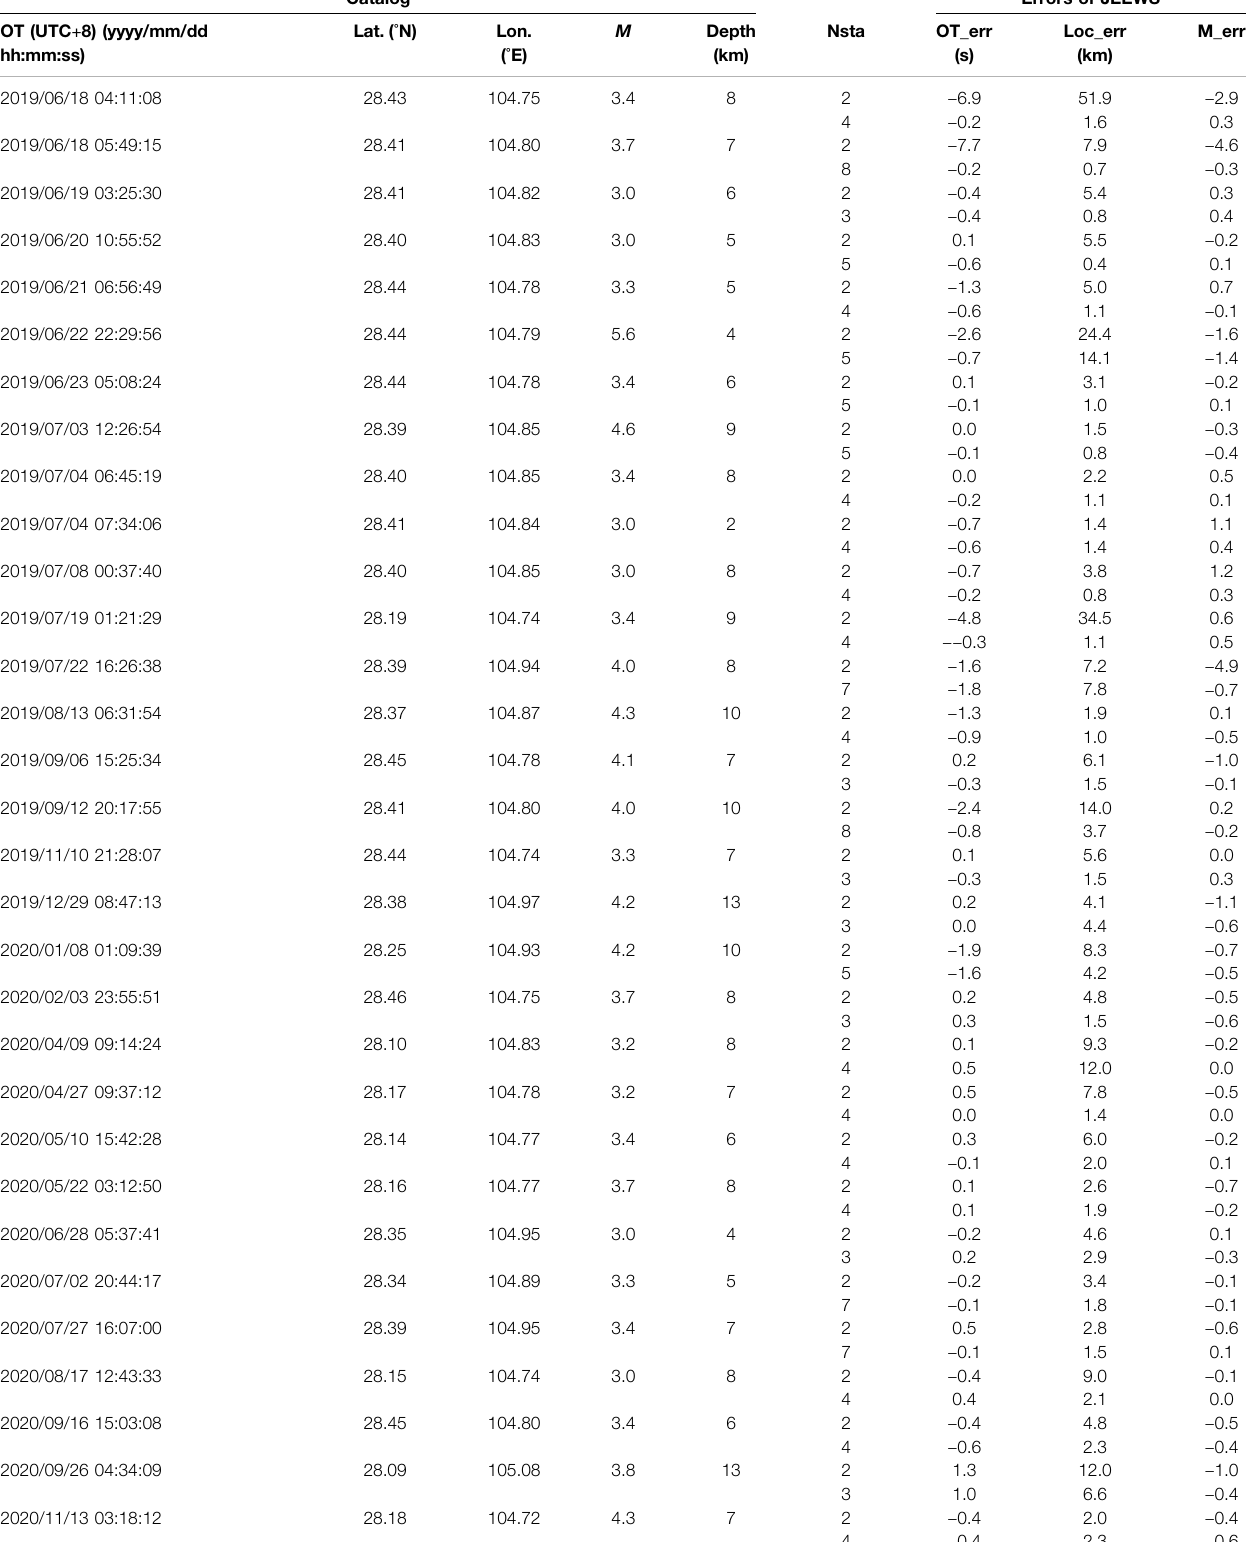
TABLE 4 | Result comparison of the same earthquakes with the fi rst alert triggered by two stations and the second alert triggered by more stations. Catalog Errors of